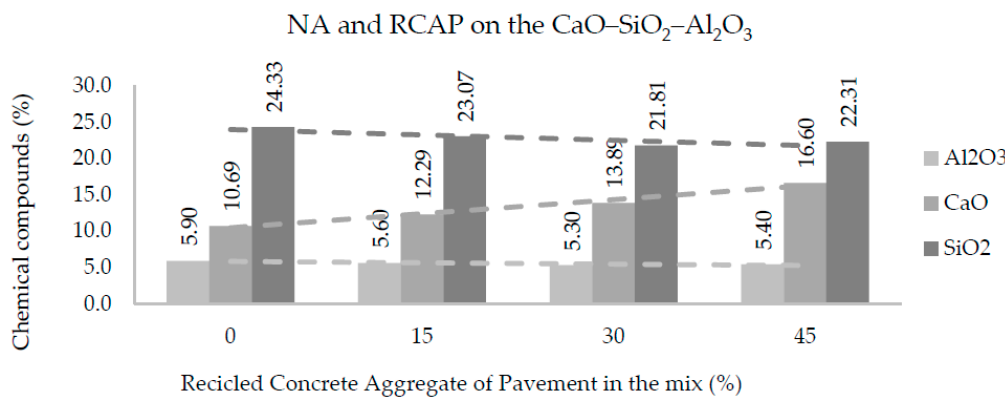
Figure 12. Effects of RCAP percentage on Al 2 O 3 , SiO 2 , and CaO contents in the mixtures of aggregates.